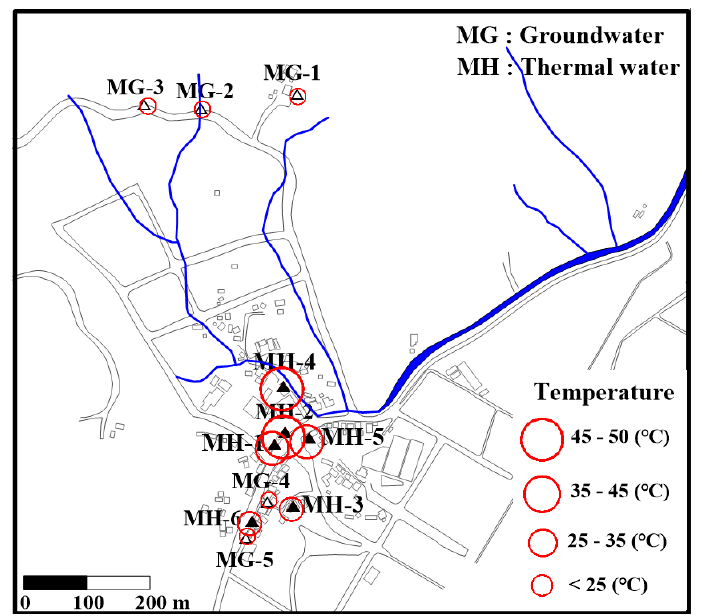
Figure 3. Map showing sample locations and temperatures of thermal water (MH) and groundwater (MG) in the Magumsan area